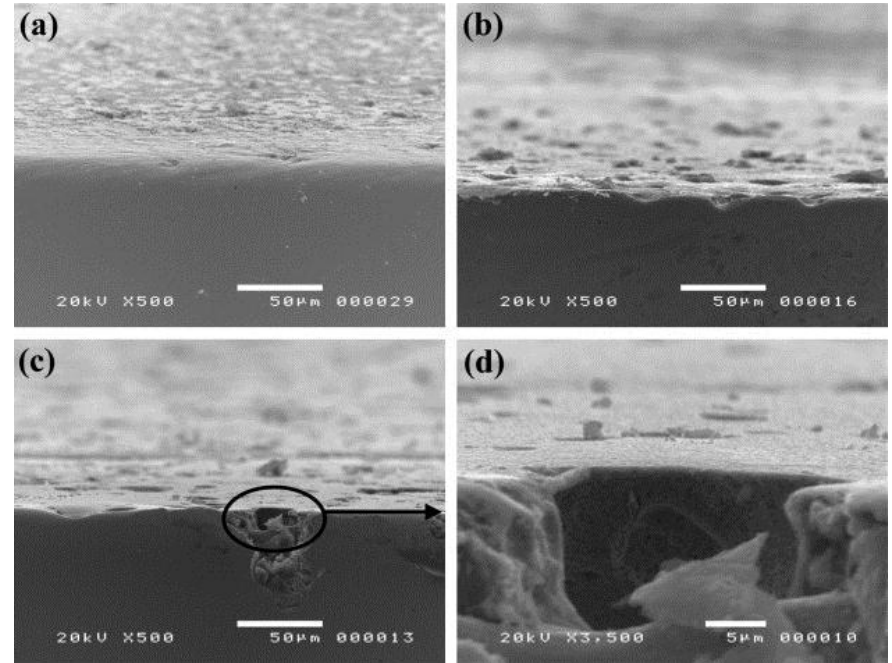
Figure 3. SEM micrographs for the Al x CrFe 1.5 MnNi 0.5 alloys with varying amounts of